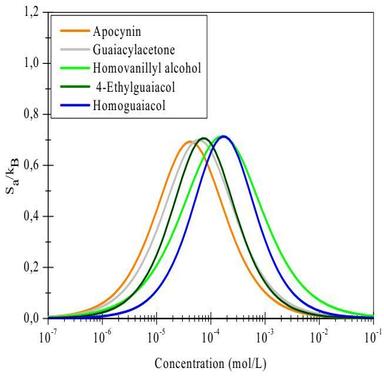
Evolution of the adsorption entropy versus the concentration for the five studied systems.